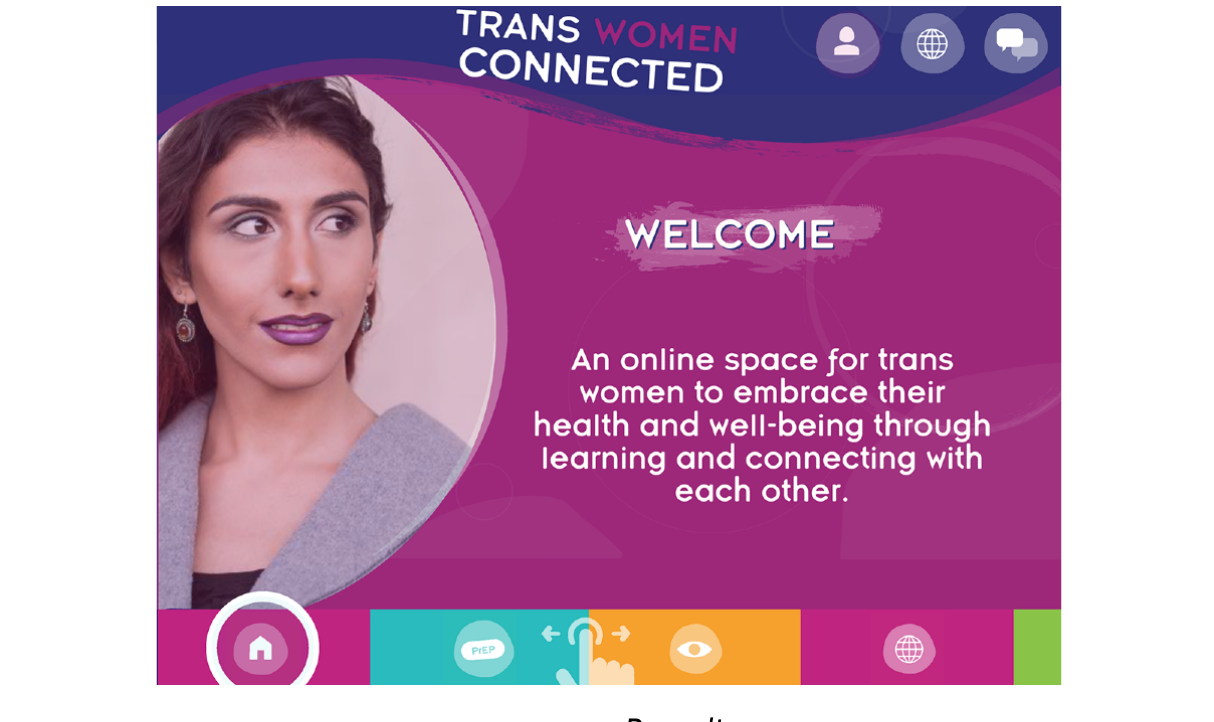
Figure 2. Welcome screen for the Trans Women Connected mobile